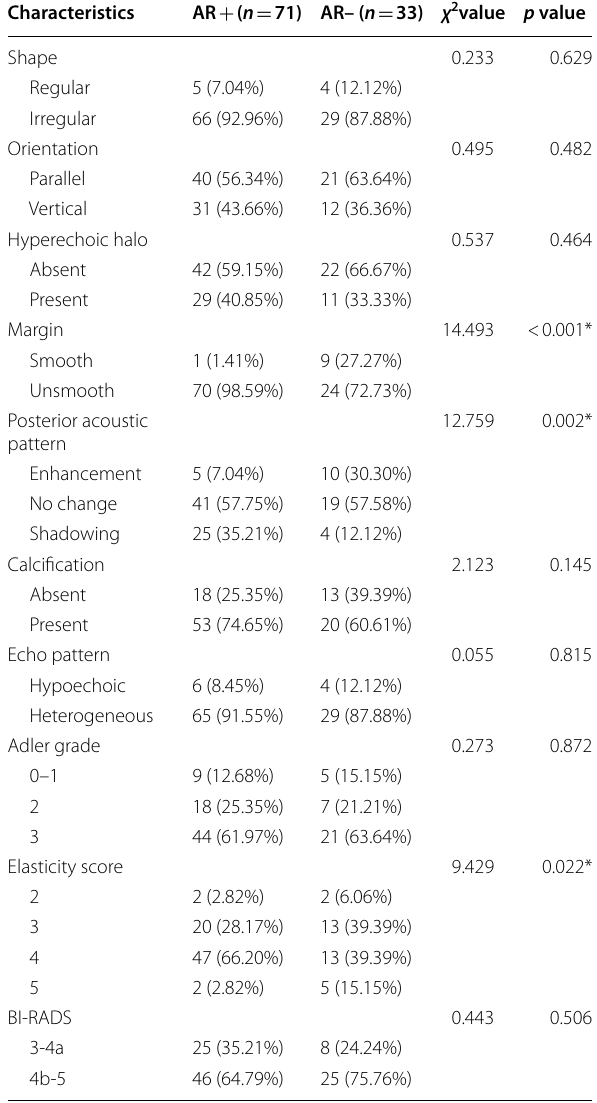
BI-RADS , Breast imaging-reporting and data system; AR , androgen receptor; * indicates p < 0.05